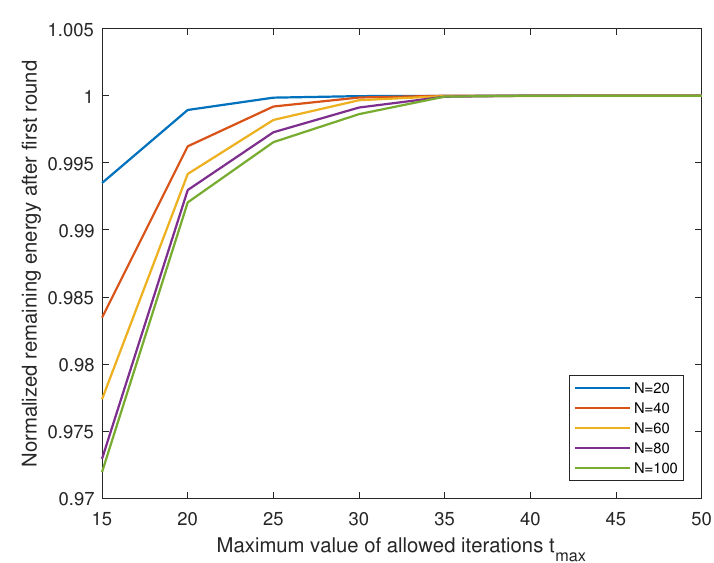
Figure 11. Convergence of LEACH-eXtended Message-Passing